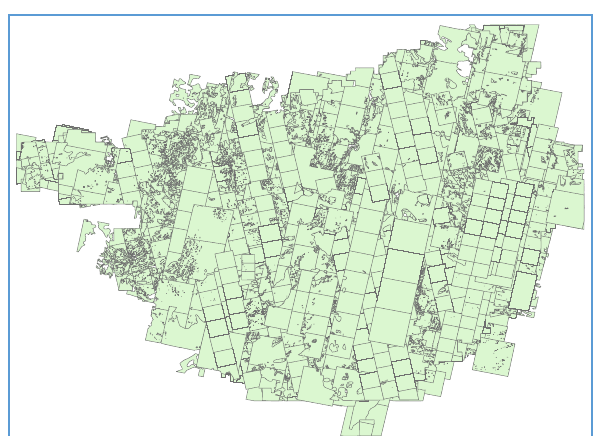
Figure 2. Store images of year 2017